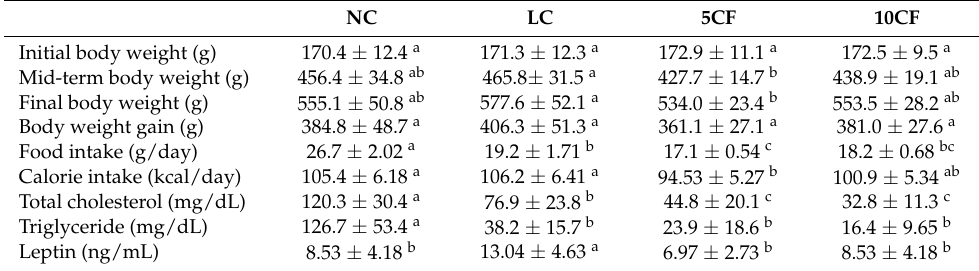
Table 4. Effects of fish oil supplementation on the body weight, food intake, plasma biochemical parameters, and tissue weights in rats fed with different experimental diets for 11